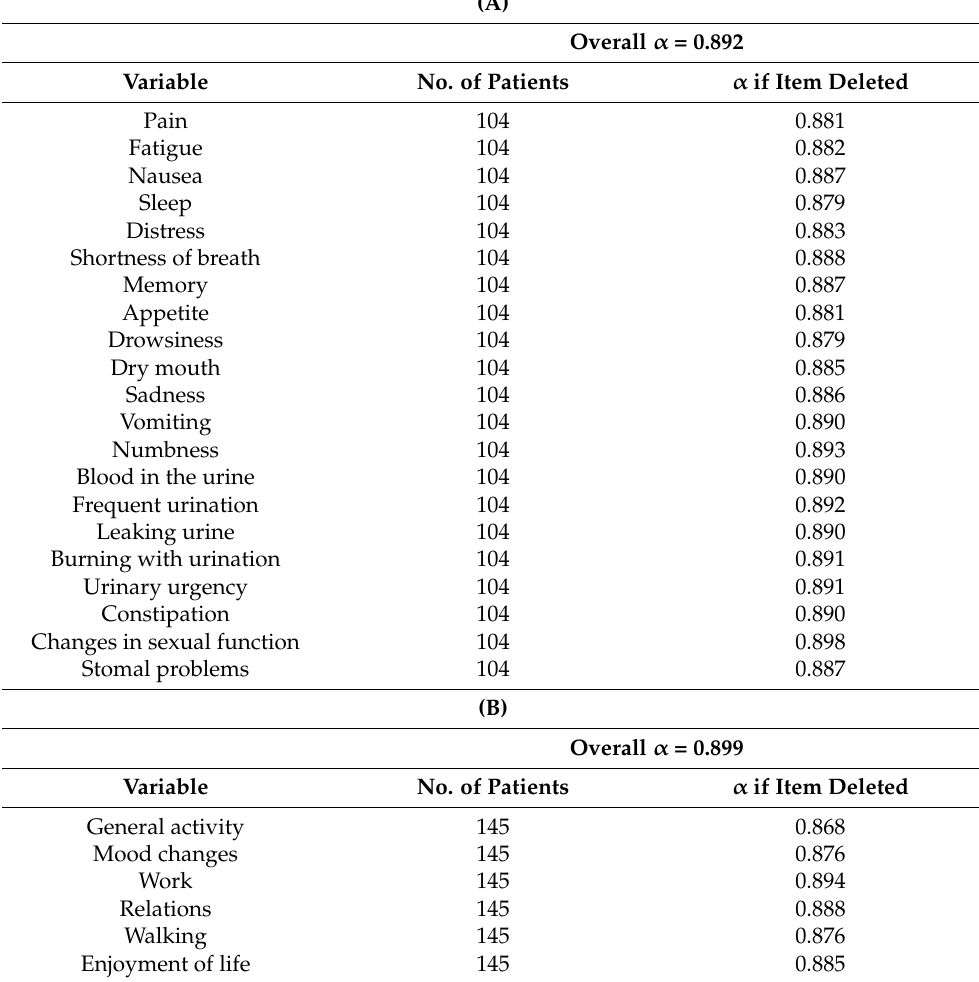
Table 2. Internal consistency of MDASI-PeriOp-BLC items according to Cronbach’s alpha. ( A ) Core and BLC module items; ( B ) Interference